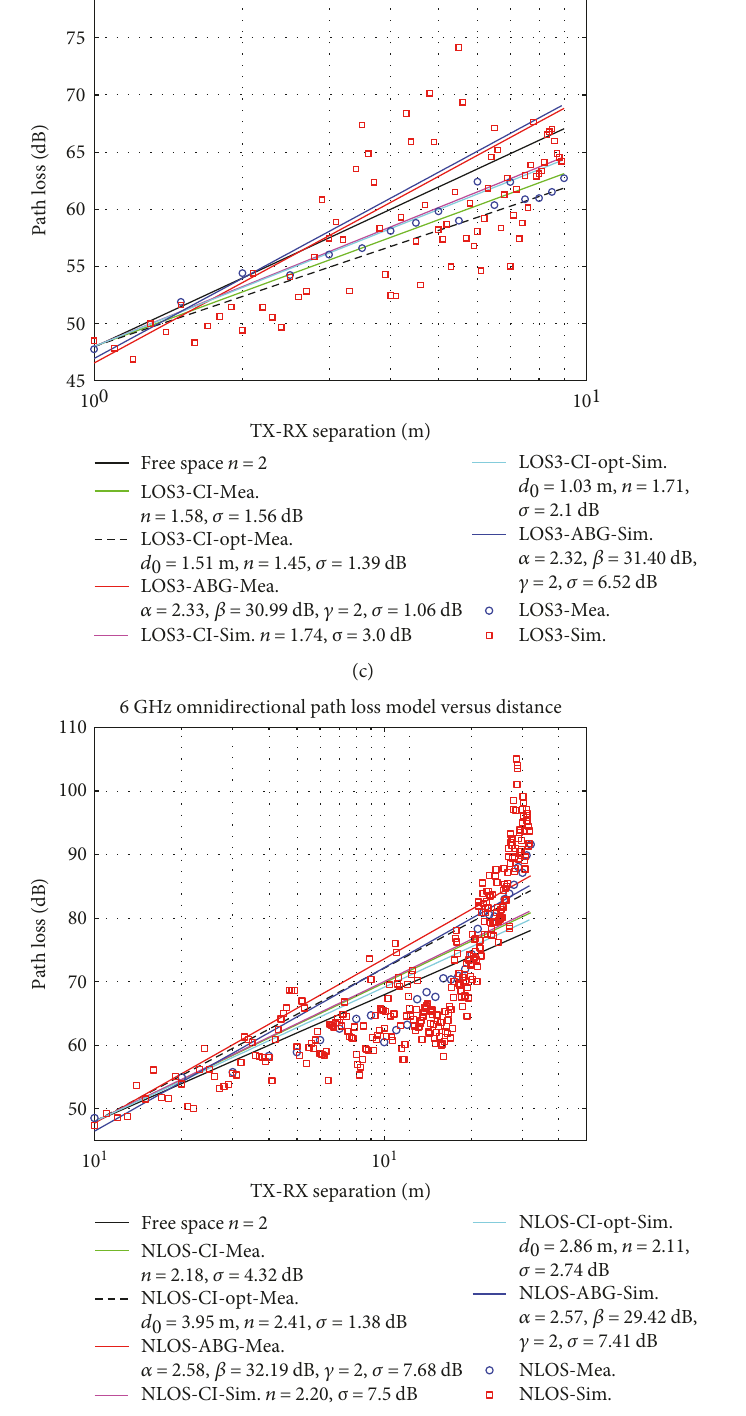
Figure 3: Path loss variation with TX-RX separation distance using CI and ABG models. (a) LOS-1 path in tunnel scenario-1, (b) LOS-2 path in tunnel scenario 1, (c) LOS-3 path in tunnel scenario 2, and (d) NLOS path in tunnel scenario